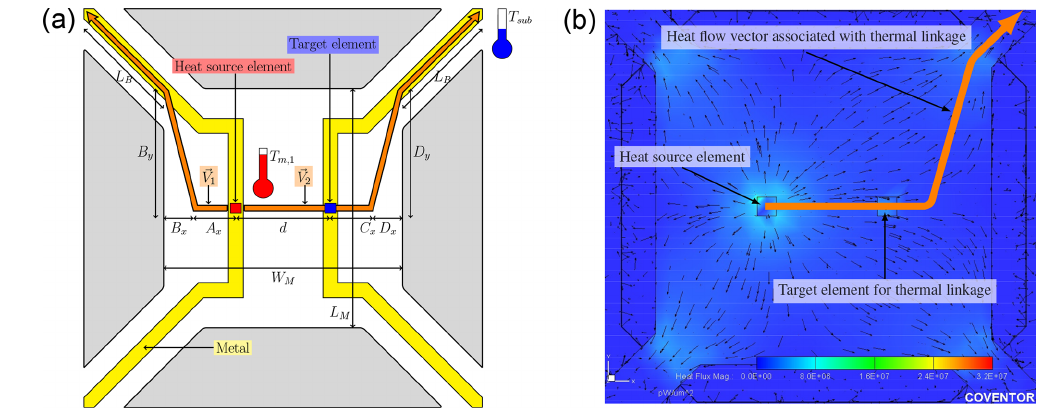
Figure 3. A graphical illustration of the heat flow vector of interest that results in thermal linkage for a dual-element suspended plate with four support beams. A simulation model with a simplified elemental heat source supports the proposal. (a) A structural overview of the device with the relevant dimensions indicated. The proposed vectors are indicated by the orange arrows, while a single heat source element is indicated as a red square and the target element on the opposing resistor is indicated by a blue square. (b) A simulation result showing the heat flow vectors from a single source element as well as the proposed heat flow vector (indicated by the orange arrow) resulting in the thermal linkage between the heat source and